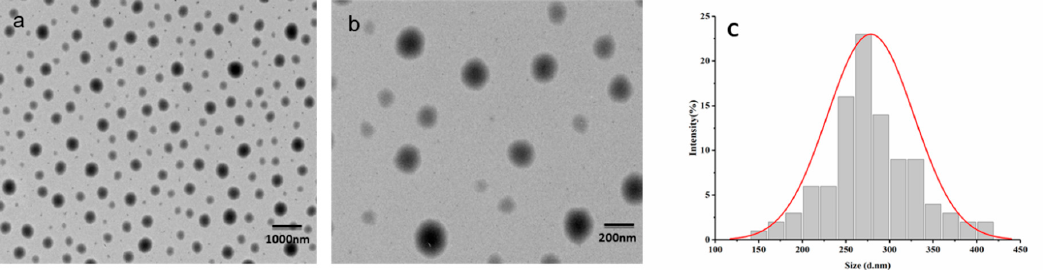
Figure 5. TEM image and particle size distribution illustration of the pyraclostrobin nanocapsules (using 5% Emulsifier 600# in the aqueous phase system, and Solvesso 100 as the solvent): ( a ) magnification of 3.0 k; ( b ) magnification of 15.0 k; ( c ) particle size distribution.